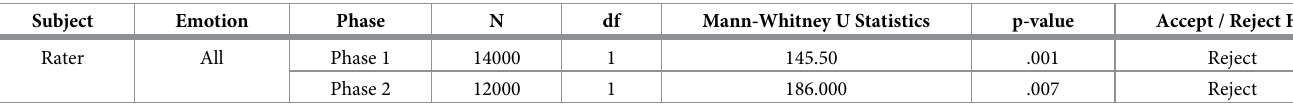
Table 23. Mann-Whitney U test for rater